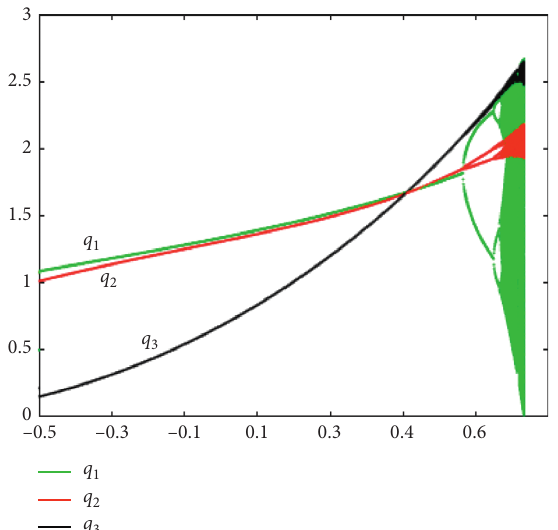
Figure 7: The bifurcation diagram of the nonlinear dynamic system (12) with d